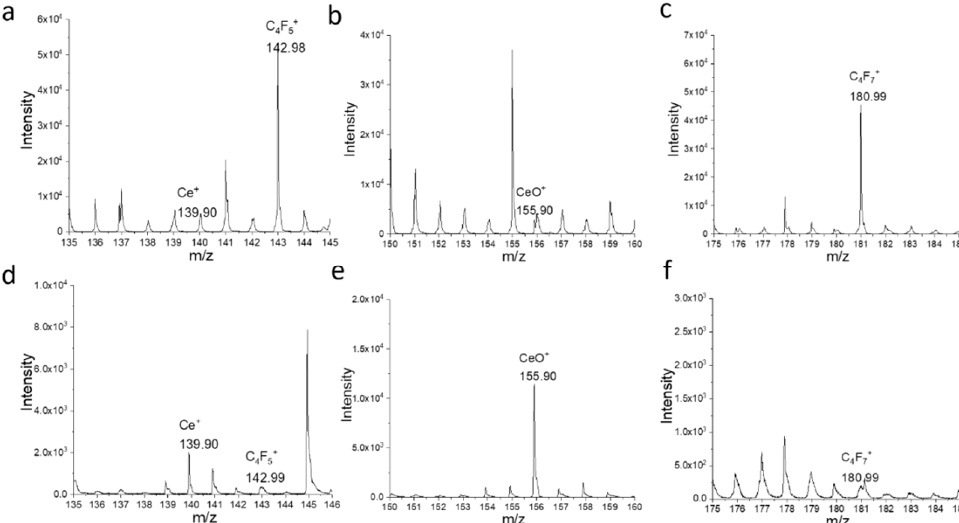
Figure 4. ToF-SIMS spectral comparison of ( a – c ) the pristine and ( d – f ) CV scanned CeO 2 WE surface. Ce + and CeO + peaks are related to CeO 2 while C 4 F 7+ is related to the Nafion membrane.